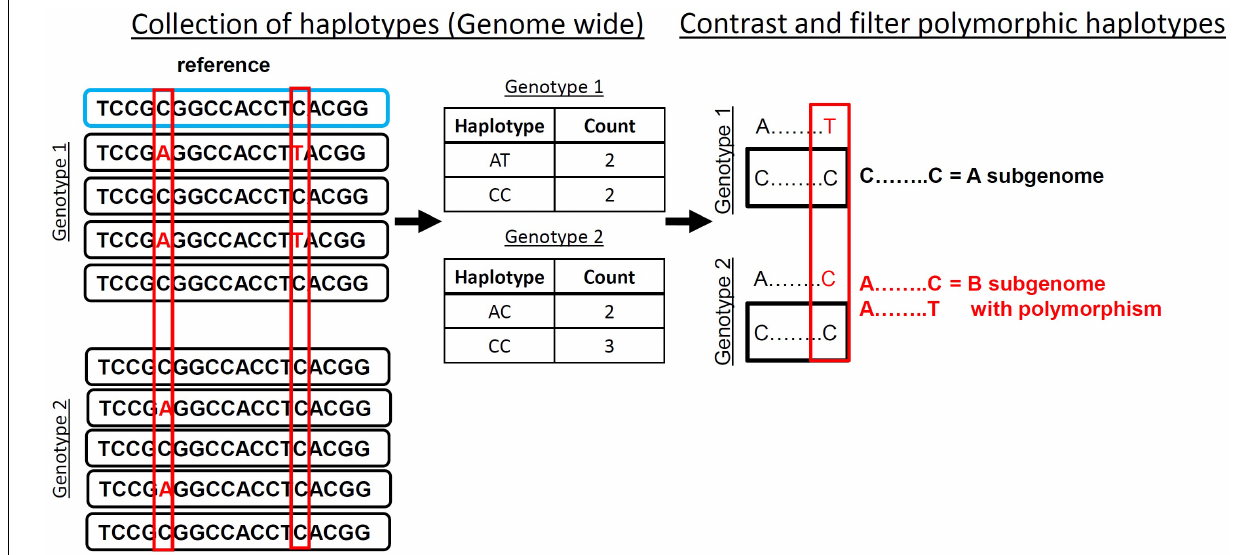
FIGURE 1 | HaploSWEEP pipeline. Top sequence (blue box) represents the reference being aligned too with reads (black boxes) representing two genotypes aligned to that sequence. All haplotypes (in polyploid mode all two base haplotypes; in diploid mode, the user can specify the length of the haplotype) are collected genome-wide that are within the user-specified read length and contain at least one potential polymorphism. Then the haplotypes are analyzed for potential haplotype polymorphisms that can be distinguished from differences between subgenomes. The filtering process, outlined in Section “Materials and Methods,” is implemented and high-quality polymorphic haplotypes are output in two different files. One file lists every observed haplotype with number of observations in each accession. The other file lists the polymorphic haplotypes for each